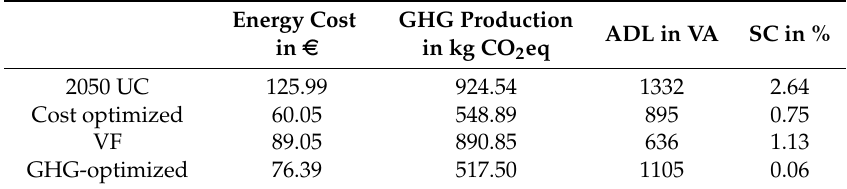
Table 3. Total energy cost, GHG emissions, average electrical distribution losses, and PV self-consumption, for different optimization approaches. Data was calculated for a winter’s week, Scenario